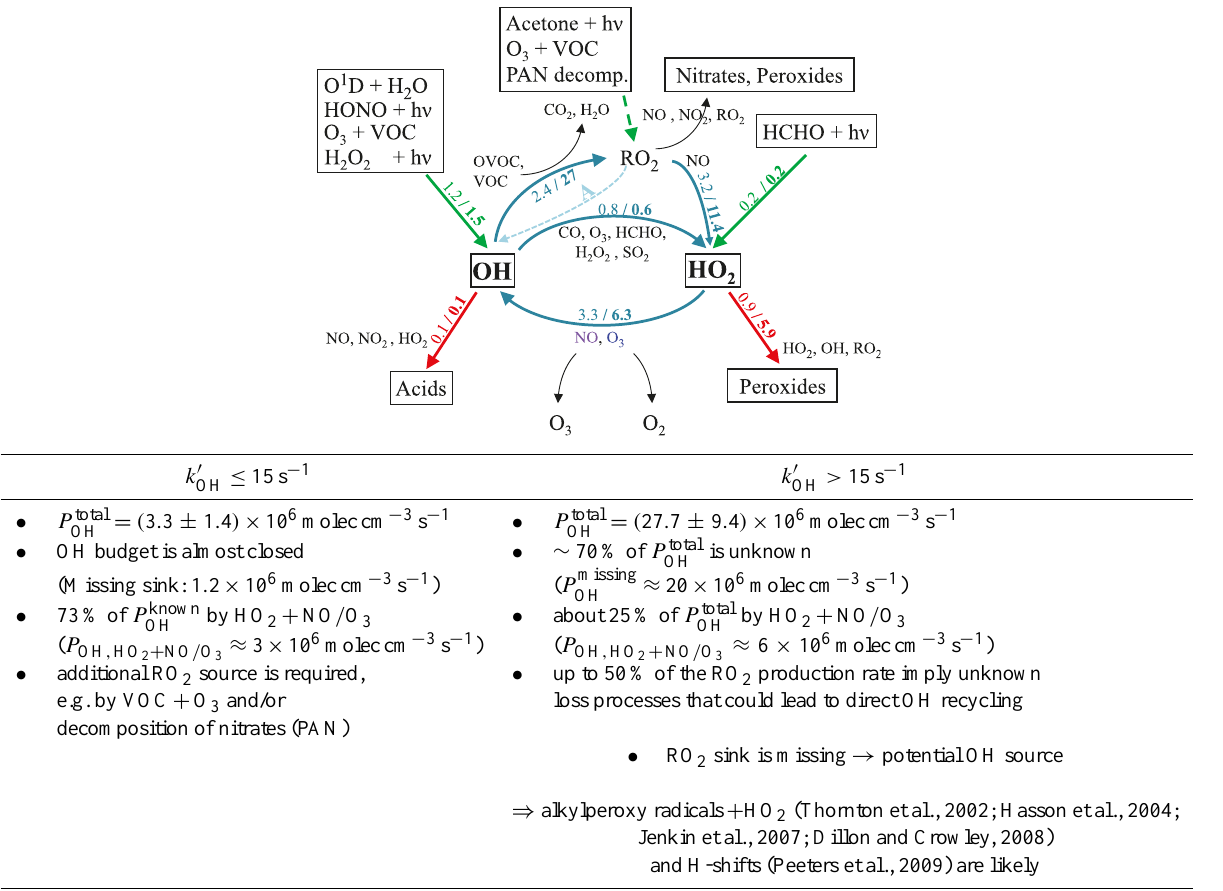
> 3 × 10 − 6 s − 1 ). O ( 1 D )